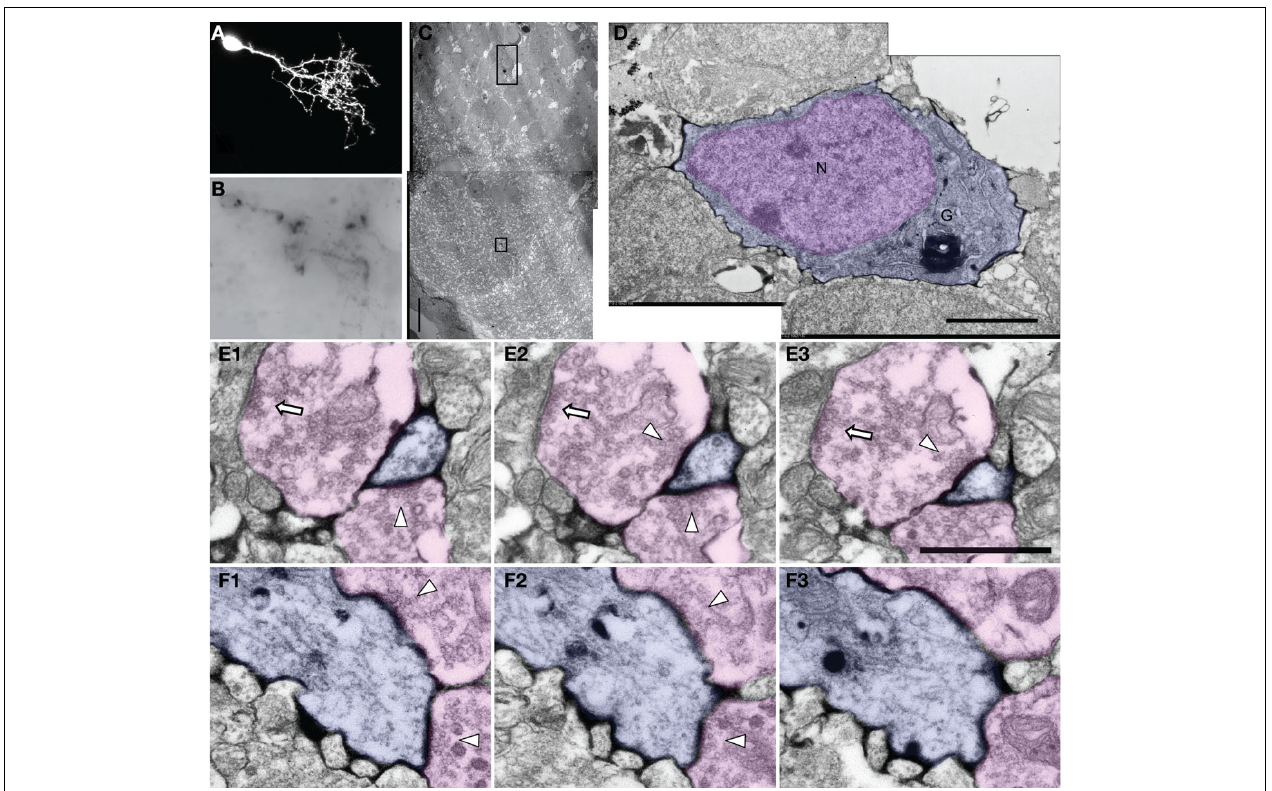
FIGURE 5 | Ultrastructure of an EGFP/mHRP labeled neuron. (A) Two-photon image of an optic tectal neuron which was labeled by single cell electroporation with co-expressed EGFP and mHRP. (B) mHRP distribution in a vibratome section through the same neuron. The distribution of mHRP was revealed by DAB reaction. (C) Low magnifi cation image of an electron micrograph showing the location of the mHRP-labeled cell body and dendritic process in different layers within the optic tectum. The cell body layer is toward the left and the neuropil layer is to the right. (D) High magnifi cation of an electron micrograph shows the ultrastructural morphology of the labeled cell